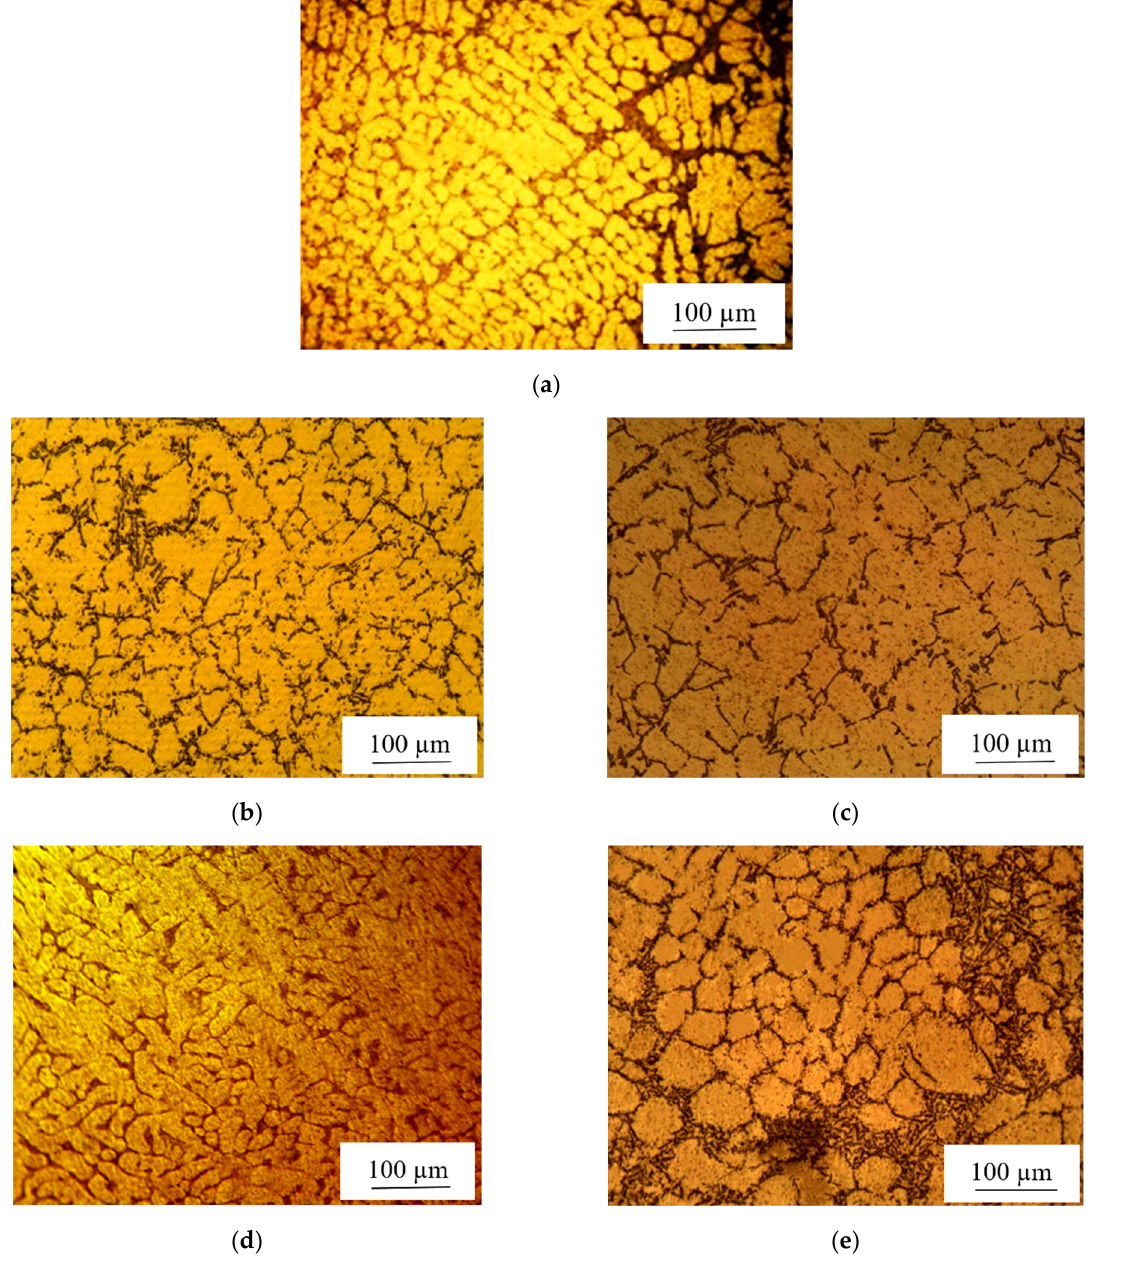
Figure 3. Typical optical images of ( a ) A356 alloy; Al alloy containing ( b ) 0.2% MWCNTs, ( c ) 0.2% coated-MWCNTs, ( d ) 0.5% MWCNTs, and ( e ) 1% MWCNTs.